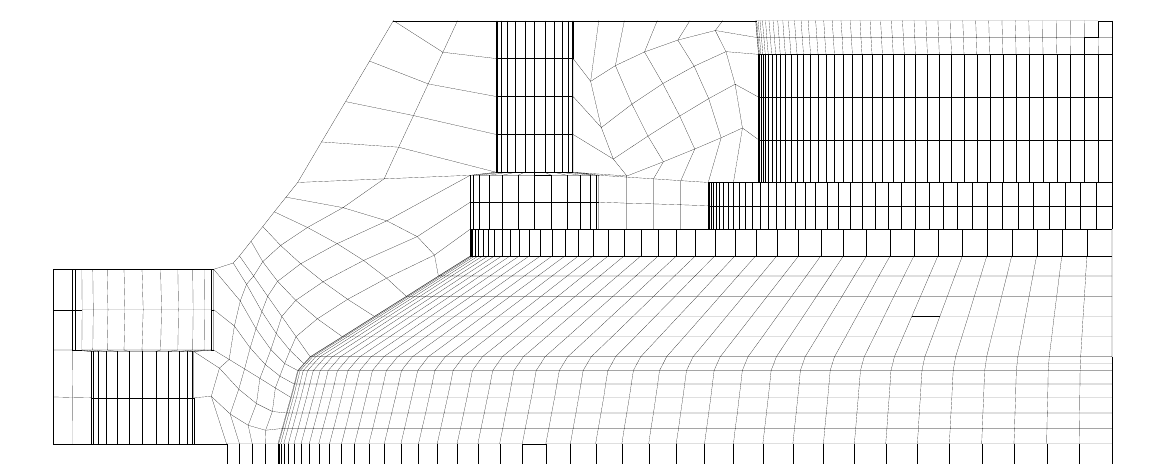
Figure 1: Vertical Kaplan turbine, with nominal output power of 200 MW.